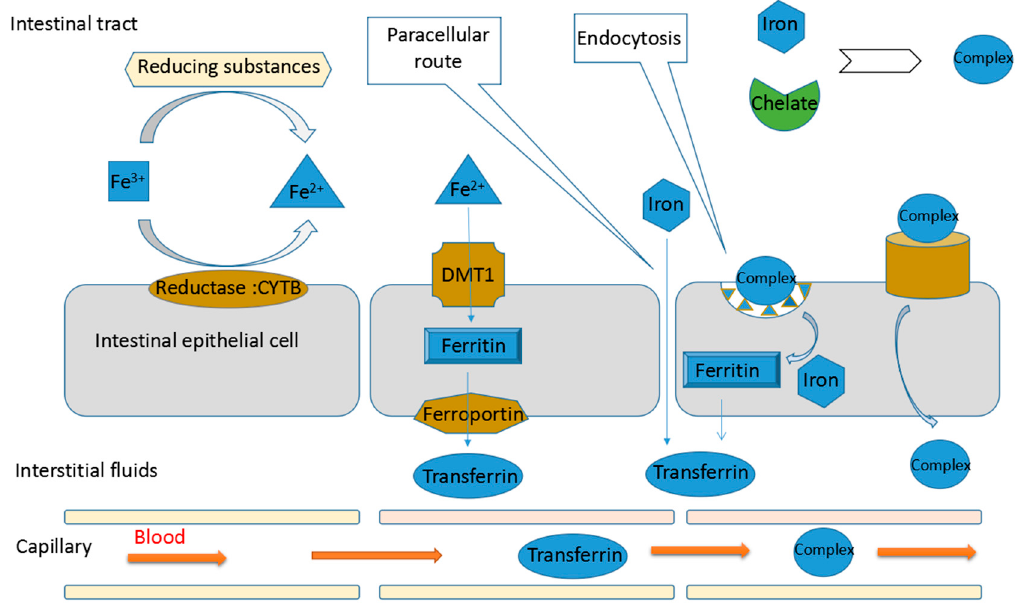
Figure 1. Mechanisms of iron absorption. Iron is absorbed both in ion and complexed forms, as well as via the paracellular route. For iron ions, Fe 3+ must be reduced to Fe 2+ by reductases, such as cytochrome b , and then be absorbed by the divalent metal transporter 1. The iron is stored in ferritin, transported out of cells by ferroportin and distributed by transferrin. In addition, iron (both Fe 2+ and Fe 3+ ) can chelate other molecules and be absorbed in the form of complexes via endocytosis and importers, after which their fate includes transformation to iron ions and transfer in their complexed form.